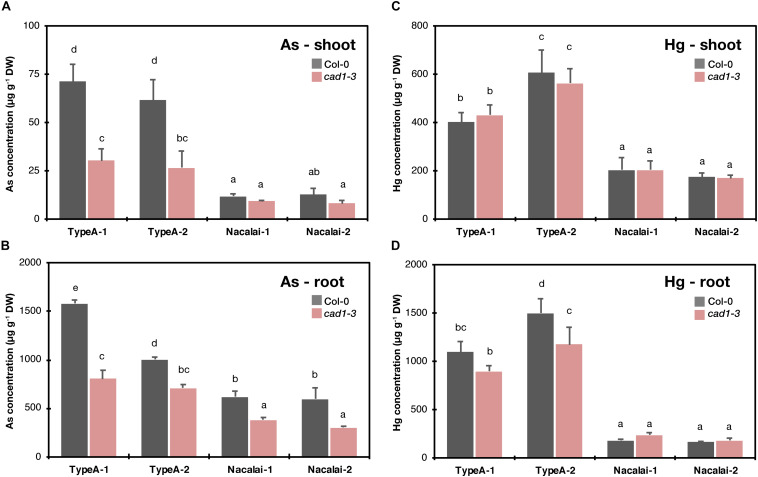
Concentrations of As in shoots (A) and roots (B) and Hg in shoots (C) and roots (D) of Col-0 and cad1-3. Plants were grown on the control medium prepared with the respective agar reagents for 10 days and then transferred to the medium containing 5 μM As(III) or 10 μM As(III). After 4 days, plants were harvested and As and Hg concentrations in shoots and roots were separately quantified by ICP-OES and CV-AAS, respectively. Data represent means with SD from two independent experiments (n = 4). Means sharing the same letter are not significantly different within each panel (P < 0.05, Tukey’s HSD).